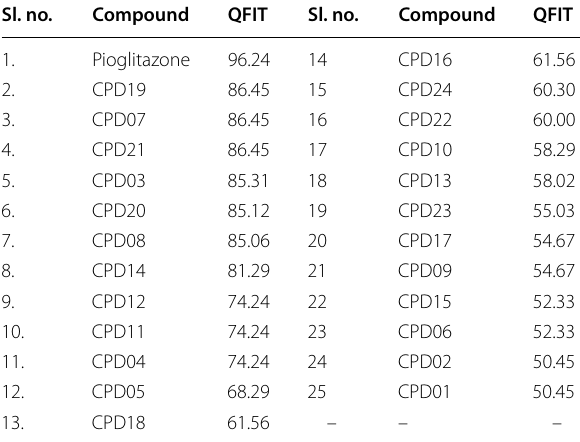
Table 1 QFIT scores of the designed